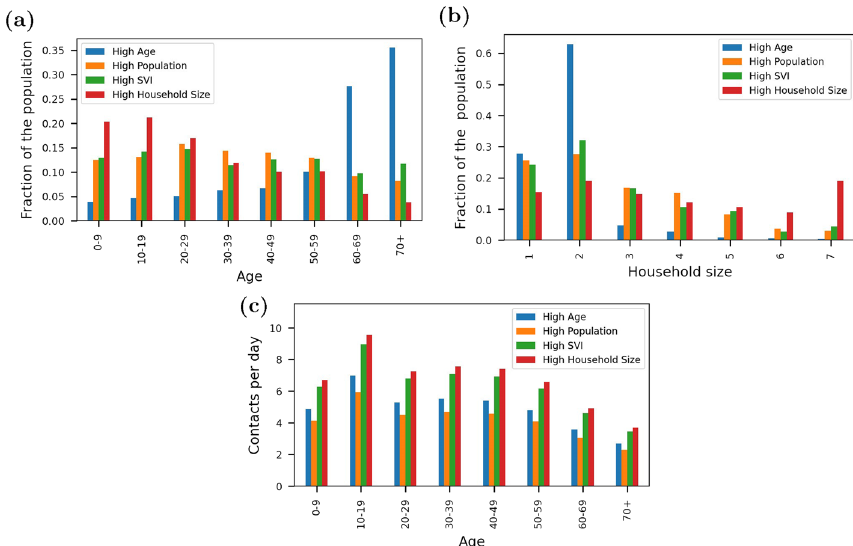
Fig. 2 Distribution of parameters used to define community networks including a age b household size and c contacts per